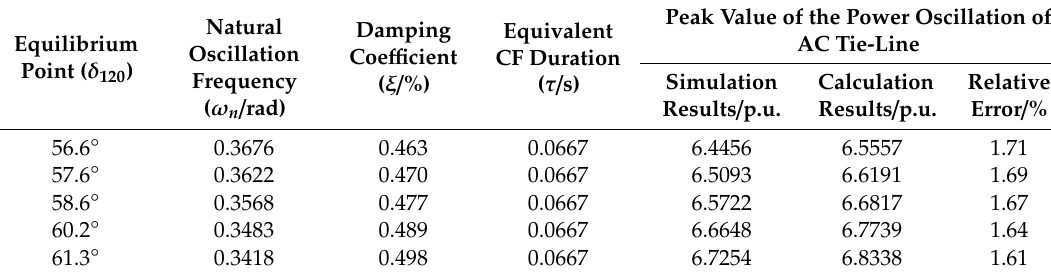
Table 1. Parameters a ff ecting the power oscillation of AC tie-line.